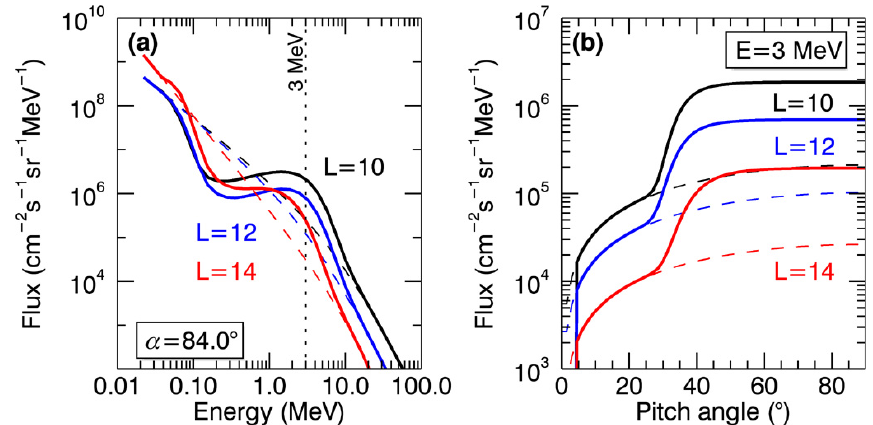
Fig. 9. Evolution of electron fluxes at selected L -shells using diffusion coefficients from varying wave intensity profile with latitude up to λ w = 30 ◦ ; solid lines are flux after 30 days, dashed lines are the starting spectra at each L -shell, and vertical dotted line in (a) shows energy used for (b)